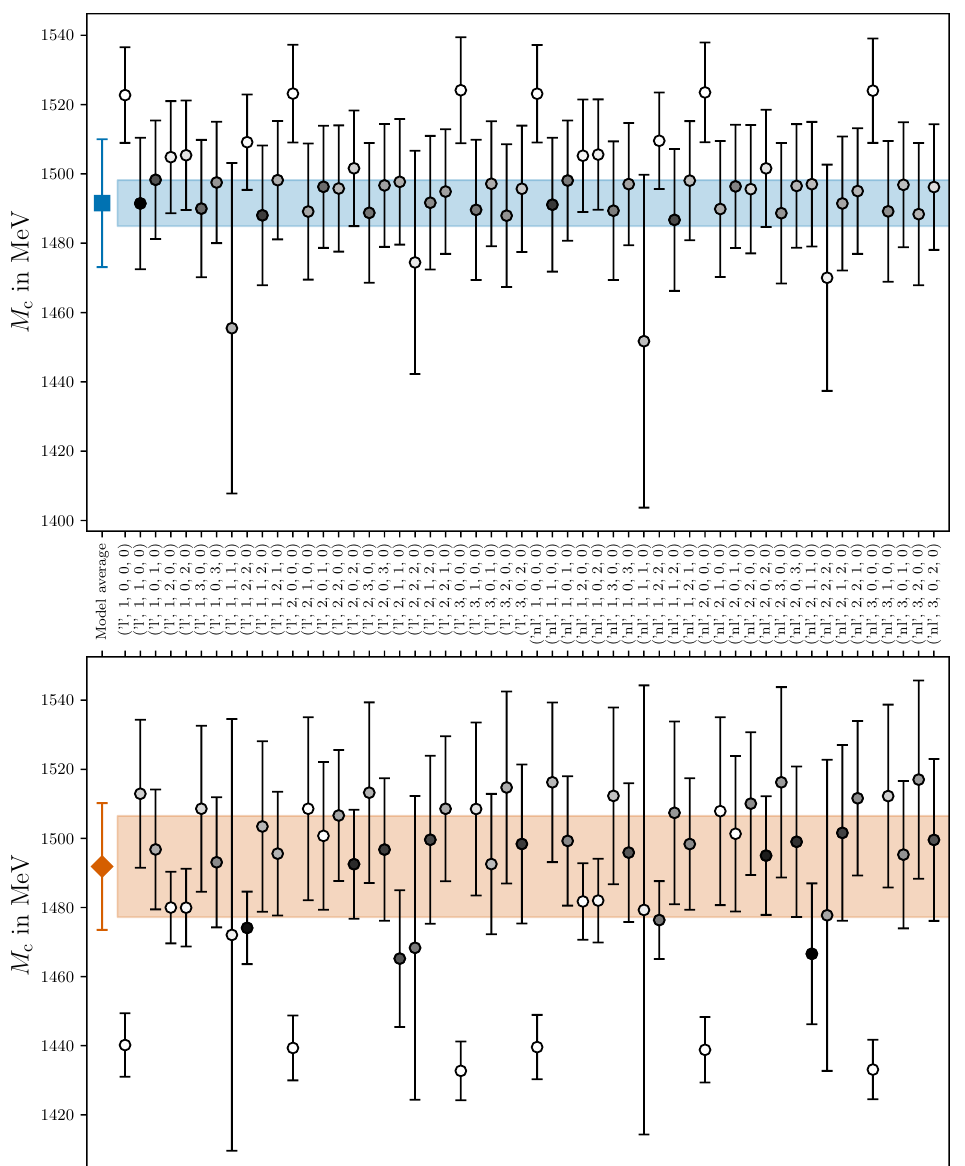
Figure 3 . Model averaging procedure for two representative categories: m R , c with m H = m ¯D , standard lattice derivative and all lattice spacings included (top panel); and m (rd) improved derivative and all lattice spacings included (bottom panel). Each circle corresponds to the result of the model indicated along the horizontal axis. The opacity of the circles is proportional to their weights contributing to the average. The filled square and diamond give the respective model averages with statistical error according to eq. (4.10), while the transparent bands indicate the systematic errors arising from the modeling procedure according to eq. (4.11), both of which are added in quadrature. Fits with pion mass dependence are not shown, as their contribution to the model averages is subdominant. Note that the model averages obtained as visualised here correspond to one data point each in the subsequent figure